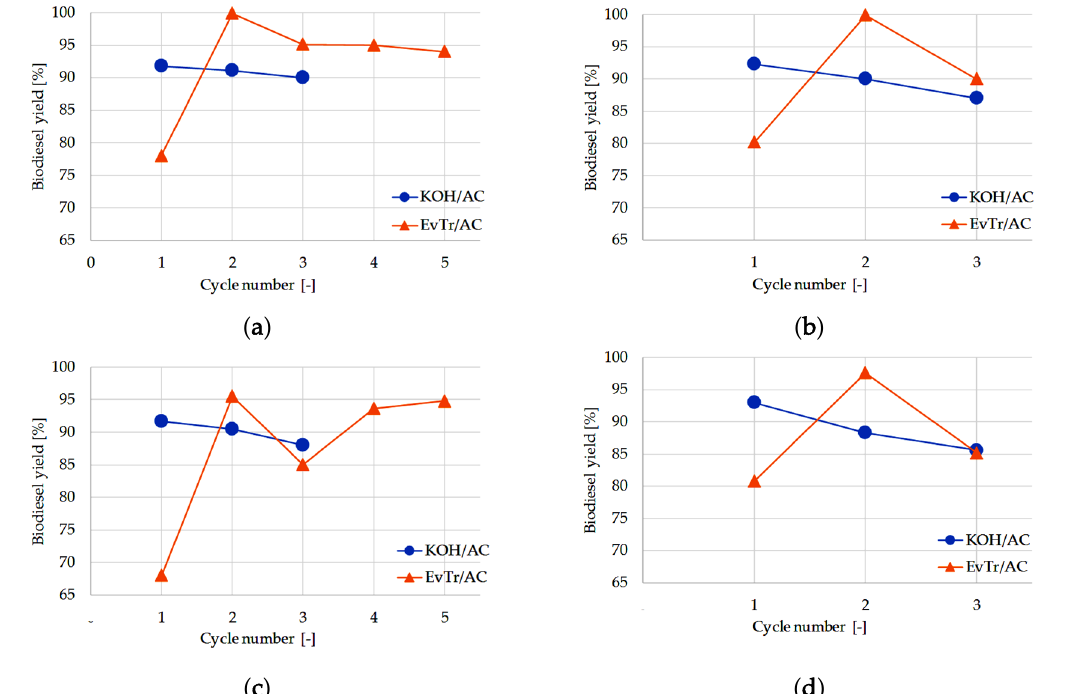
Figure 4. The yield of biodiesel obtained from vegetable oils reusing KOH / AC and EvTr / AC. [( a ) biodiesel obtained from corn oil, ( b ) biodiesel obtained from sunflower oil, ( c ) biodiesel obtained from rapeseed oil, ( d ) biodiesel obtained from olive oil].